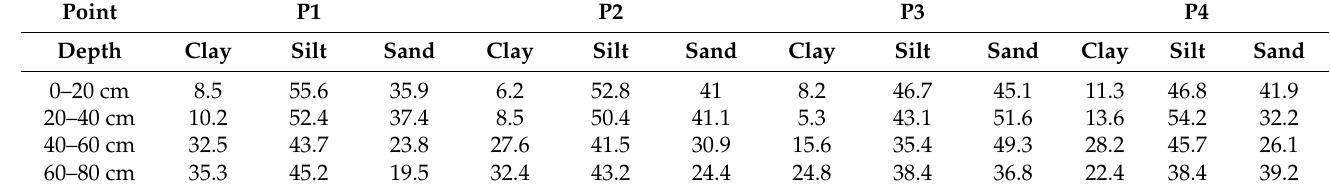
Table 2. The percentage composition of soil texture (clay, silt and sand) at different depths.